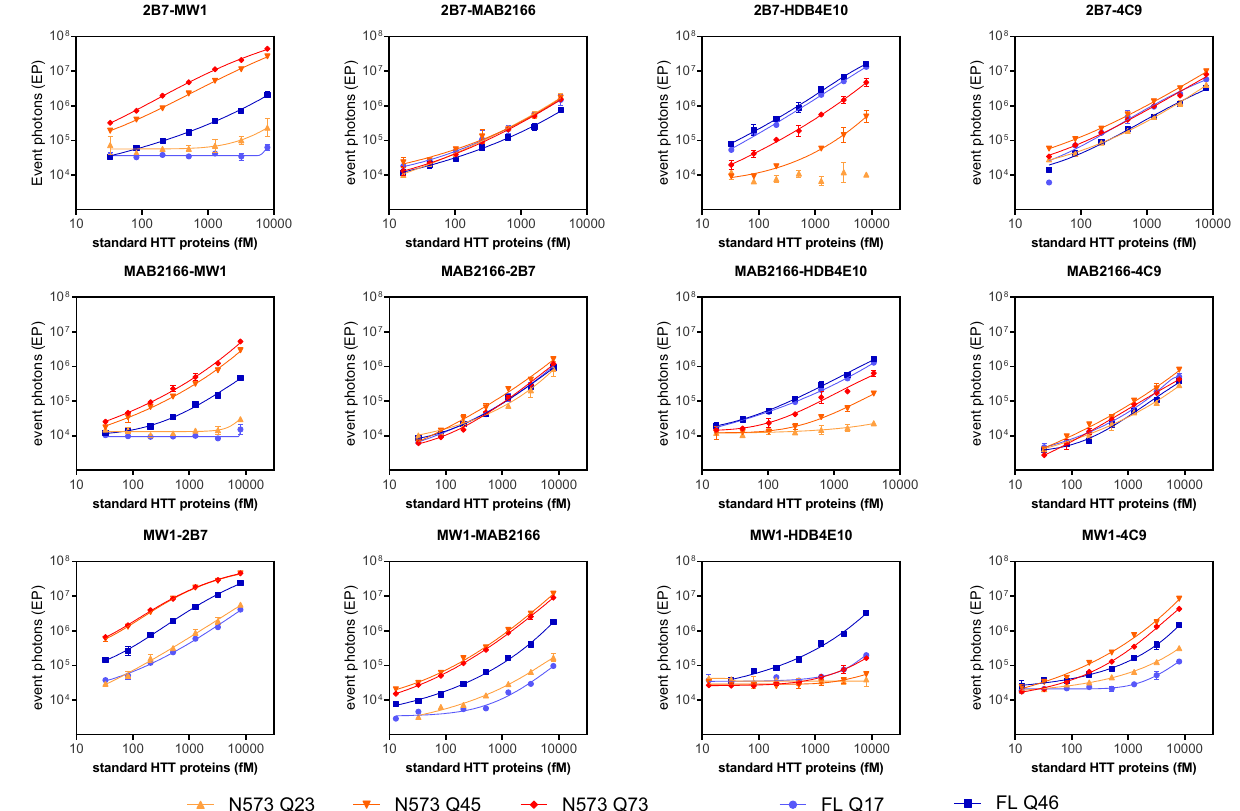
Figure 2. Performance of the standard curve detection by all antibody pairs. The five standard HTT proteins (N573 Q22, N573 Q45, N573 Q72, FL Q17, FL Q46) were serially diluted from 8 pM and assayed via SMC using the antibody pair reported on the title of each chart; the first mentioned antibody was used as capture whereas the second was used as detection. Each experimental point is reported as the average and standard deviations of a